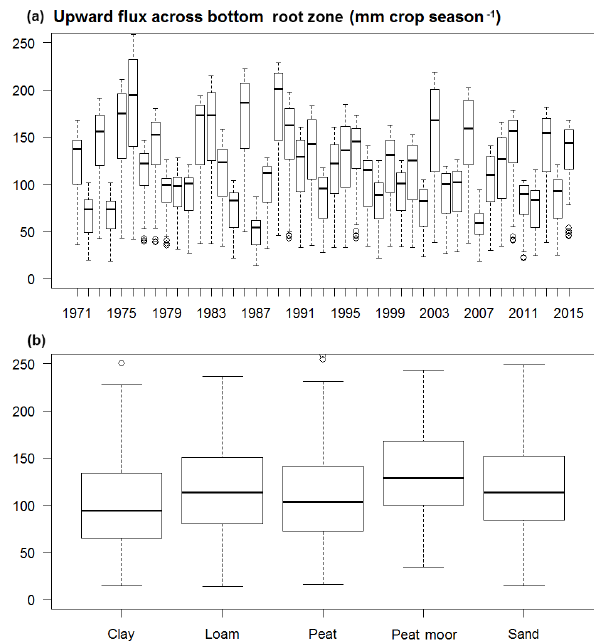
Figure 6. Results of the soil–crop experiment for potato: up- ward flux across the bottom of the root zone ( q recirc in mmcropseason − 1 ) for hydrological conditions with free drainage (FD rc ) : (a) for results for all 72 soils for the period 1971–2015; (b) for results as box plots for clustered soil types.